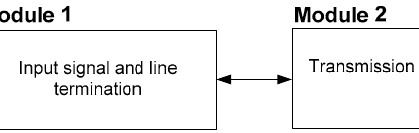
Figure 8. An overview of an LTSpice simulation scheme.